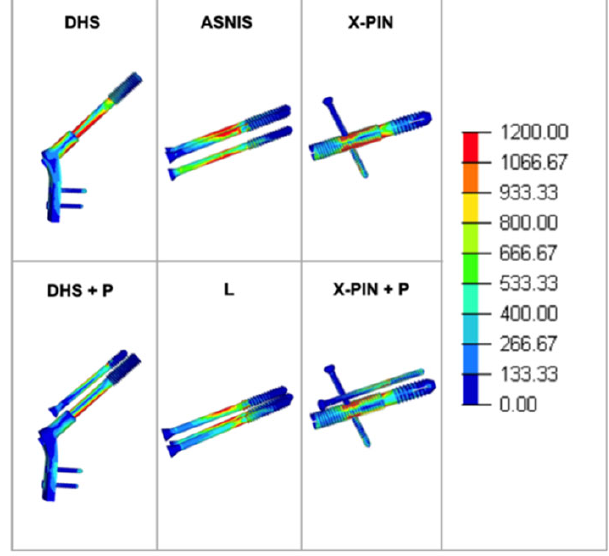
Figure 10. Von Mises stress in each group.